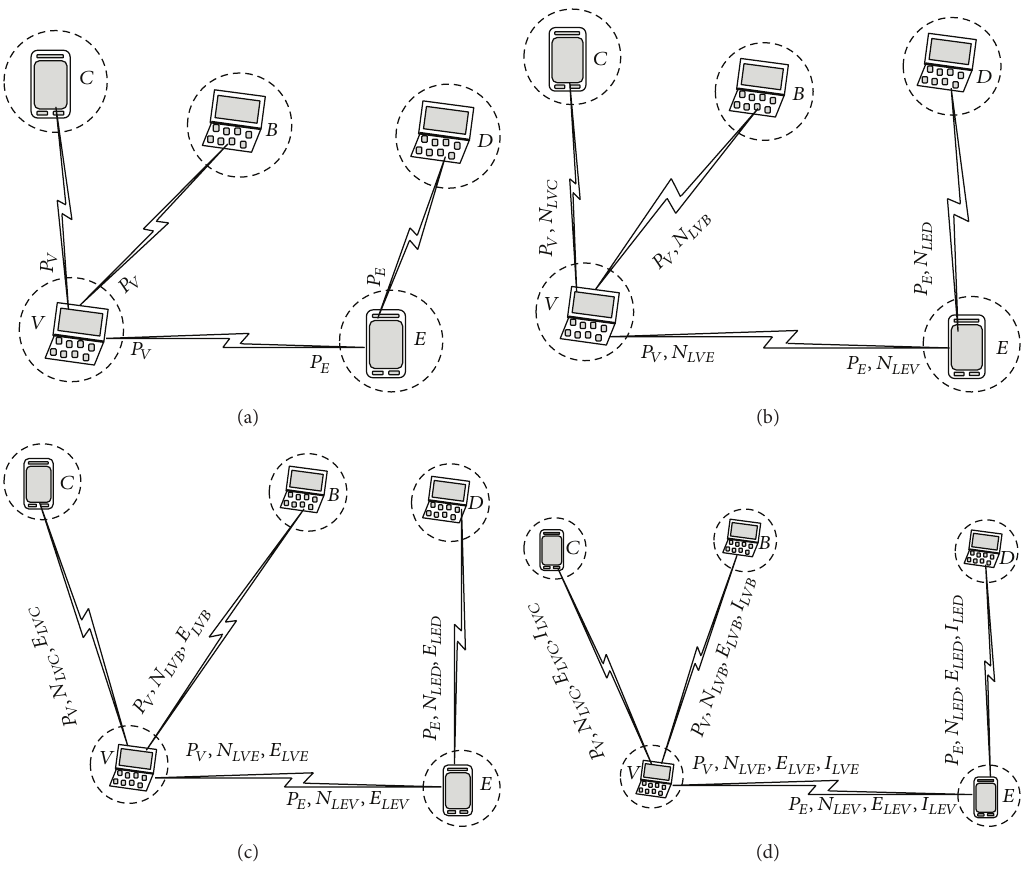
Figure 1: Weight determination of